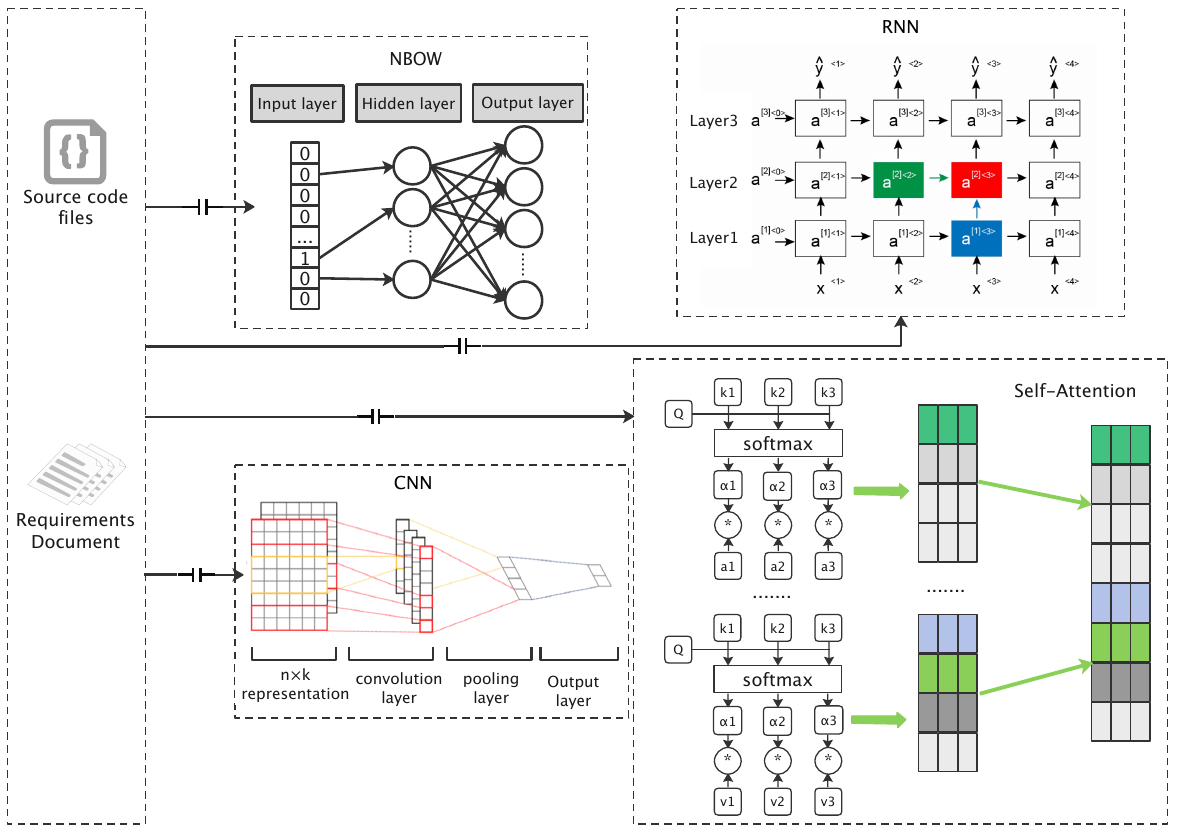
Figure 2. Requirement and source code embedding layer model based on neural